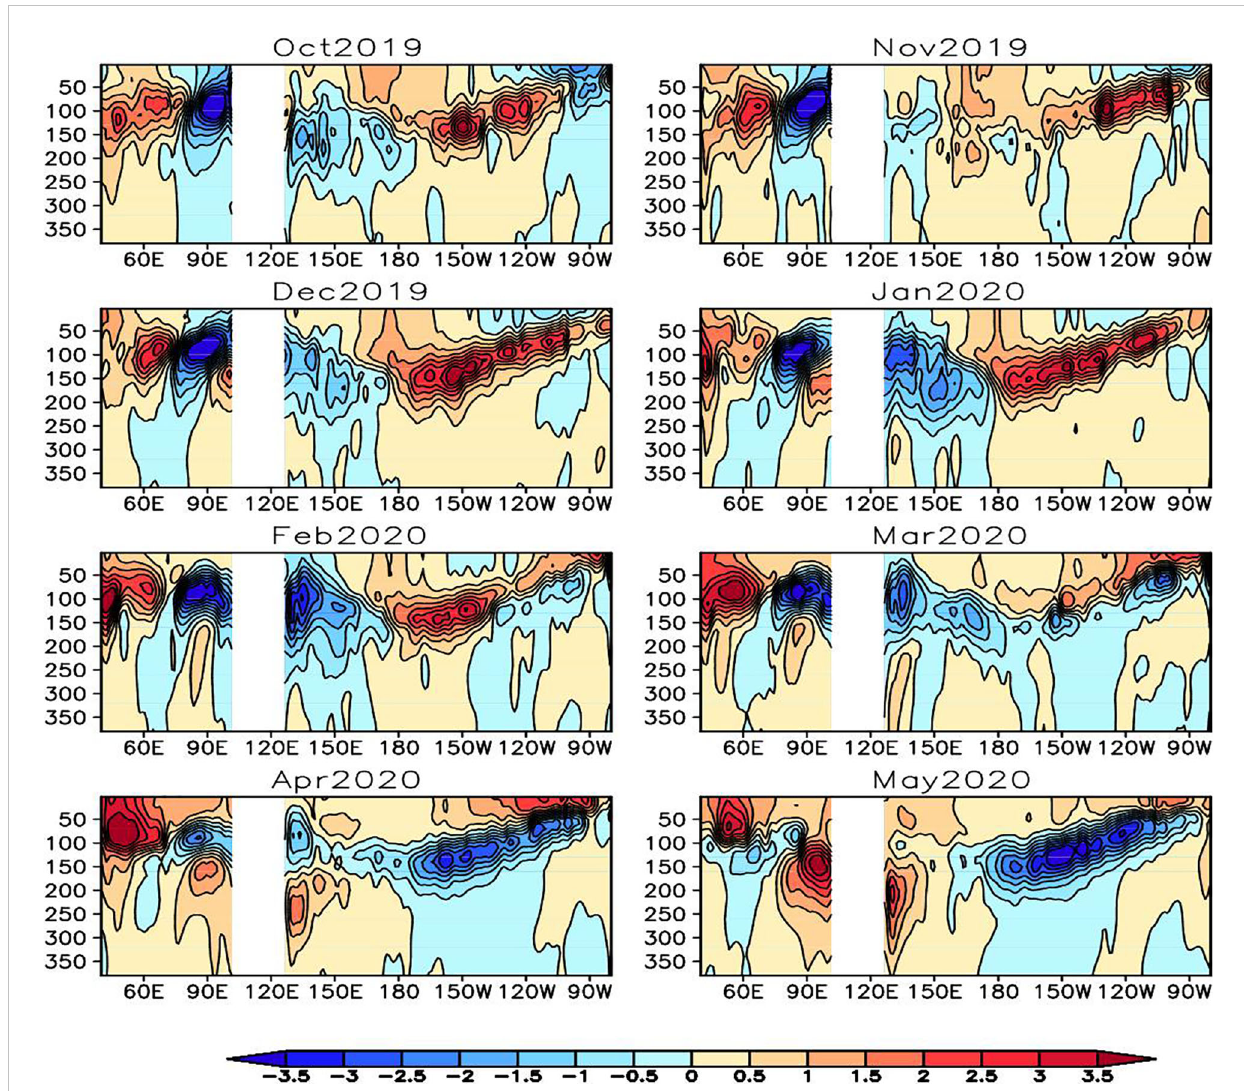
FIGURE 4 The propagation of the Kelvin waves over the Indo-Paci fi c Ocean during 2019-2020. Monthly Argo temperature anomalies (°C) over the equatorial Indian and Paci fi c Ocean (5°S-5°N) during